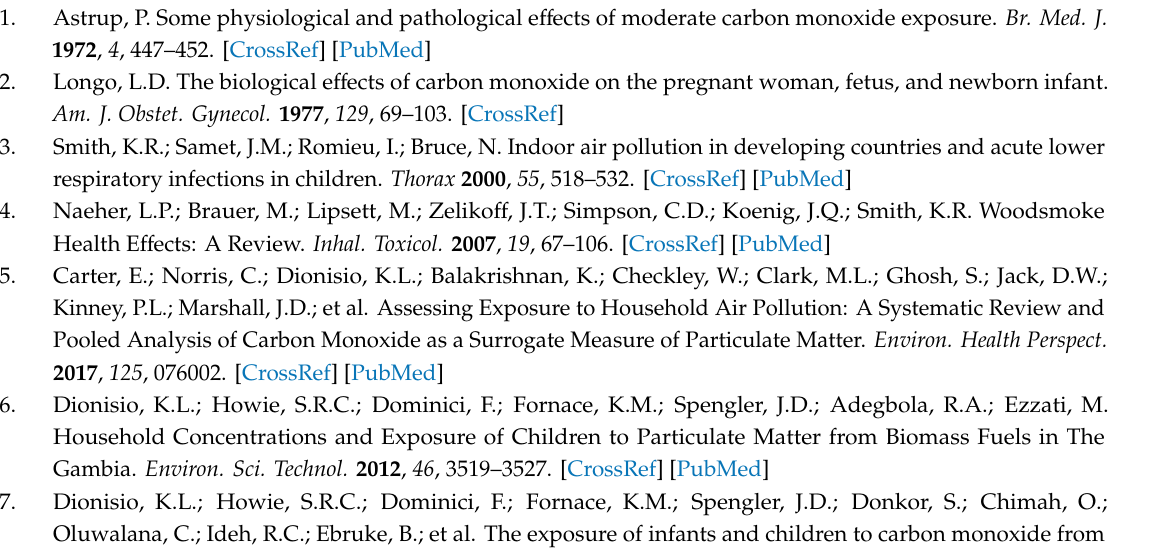
Figure S1: Lascar CO monitors worn on lanyards around the neck or placed inside custom pockets on project t-shirts, Figure S2: Distributions of average CO exposure by time periods relevant to WHO tier-1 standards, Figure S3: Example calibration of a Lascar that returned from the field after deployment to Navrongo, Figure S4: Lascar USB-CO calibration and data quality time line. Some Lascar monitors like #1 and #3 never operated correctly and were returned to the manufacturer. In most cases, the monitors were non-operational upon their return to the CU Boulder Hannigan Lab, so a post-calibration could not be performed, Figure S5: Agreement of daily average Lascar USB-CO duplicates for both calibrated and raw values colored by days since first deployed, Figure S6: Personal exposure by season and stove group, smoothed using b-splines, Figure S7: B-spline smoothed personal CO exposure grouped by primary cook status gender group. ‘0’ values are for non-primary cooks, and ‘1’ is for the females listed as primary cooks. No males were listed as primary cooks, Figure S8: B-spline smoothed personal CO exposure grouped by age and gender group. ‘0’ values are under 5, and ‘1’s are over 5 years of age, Table S1: Descriptive 24 h average CO exposure